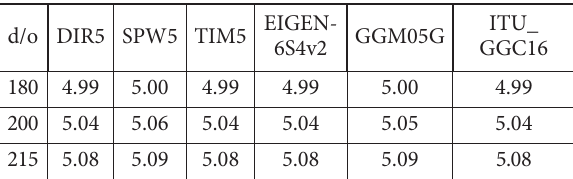
Table 4. RMS of gravity anomaly differences in mGal for pure satellite GGMs up to d/o 180, 200 and 215 after SEM d/o DIR5 SPW5 TIM5